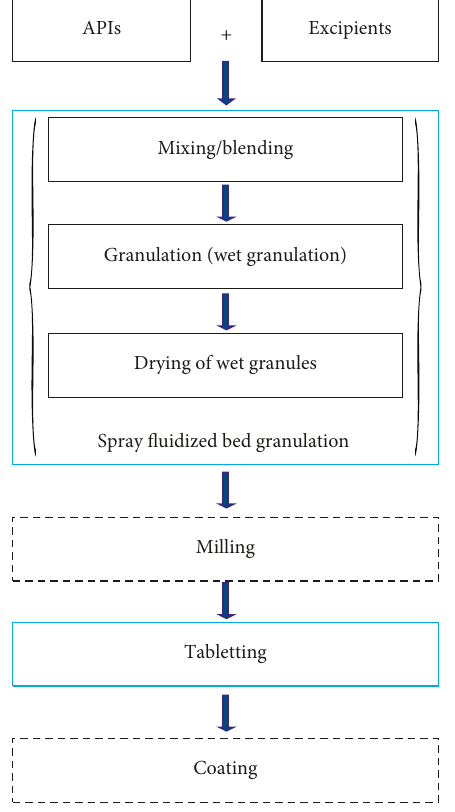
Figure 1: Schematic diagram of typical PTMP via wet